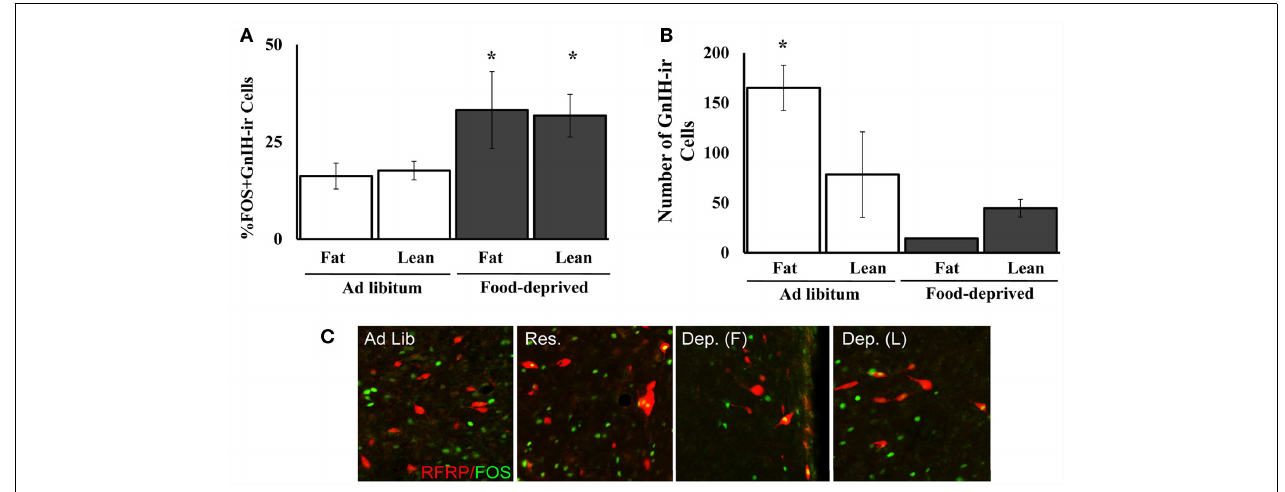
food-deprived hamsters were lean and the other half were fattened prior to the start of food deprivation in Experiment 2A. (C) . Photomicrographs of GnIH/Fos-Ir in the groups described. *Significantly different from ad libitum at P < 0.05.